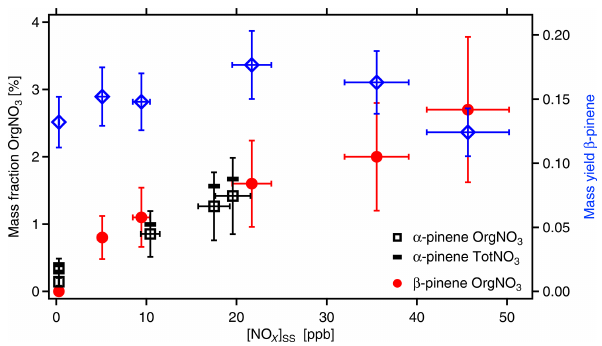
Figure 7. Mass fraction of organic-bound nitrate (OrgNO 3 ) in SOA as a function of [NO x ] SS (left y axis). Black squares and red circles show data measured from α -pinene and β -pinene, respec- tively. SOA mass yields are shown for the respective experiment with β -pinene (blue diamonds). The SOA load ranged from 11 to 23µgm − 3 with an average of 16 ± 5µgm − 3 . The data are corrected for wall losses of HOMs. In absence of OH, [ α -pinene] 0 was around 46ppb, and [ β -pinene] 0 was around 37ppb. NO x was added at dif- ferent amounts with [NO x ] 0 up to 103ppb. Due to losses in reac- tions with OH and formation of organic nitrates, [NO x ] decreased to the [NO x ] SS levels shown here. Uncertainties in NO x data are estimated to ± 10%, uncertainties in SOA masses to ± 10%, and uncertainties in the content of OrgNO 3 to ± 40%. The black bars indicate the fraction of total nitrate (TotNO 3 , left scale) for the ex- ample of α -pinene, which is dominated by organic